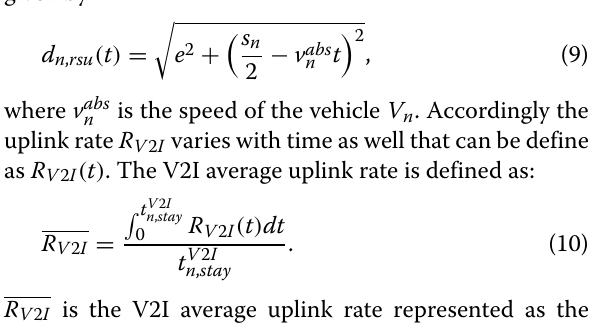
uplink data rate is defined